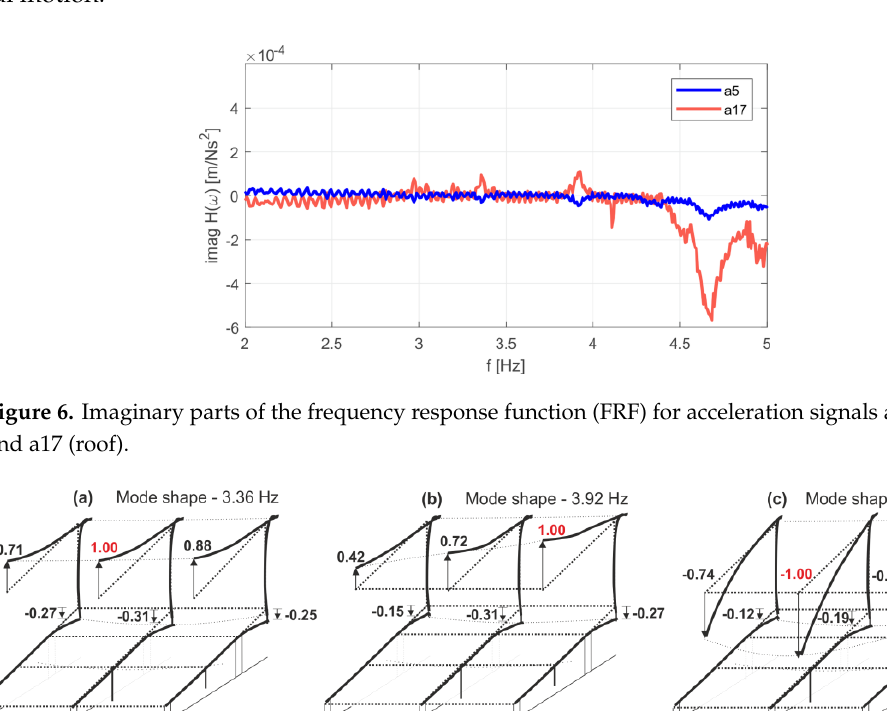
Figure 8. Dynamic tests with fans: ( a ) experimental setup, ( b ) scheme showing the arrangement of people during tests (orange color—rows indicating the most unfavorable fan positions) .